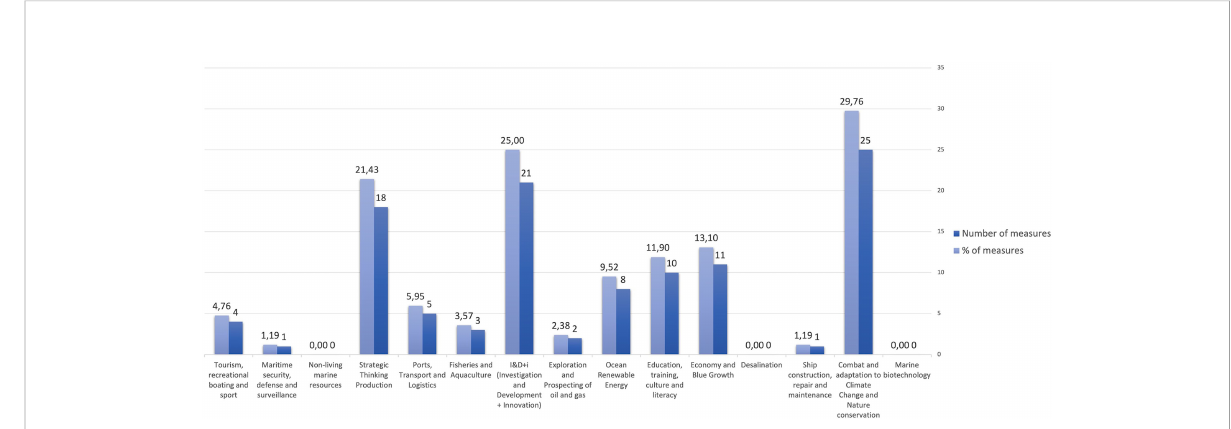
FIGURE 6 Number of identi fi ed measures, and corresponding percentage, by socio-economic sector, of Ireland ’ s National Ocean Strategy. Source: Created by the